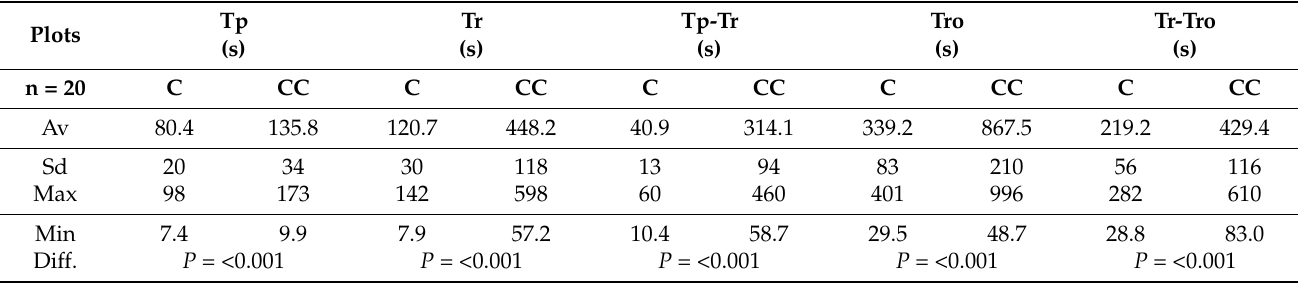
Table 3. Runoff parameters related to the hydrological responses in the catch crops (CC) and control plots (C). Av: Average; Sd: Standard deviation; Max: Maximum; Min: Minimum. Diff.: Differences. Tp: Time for ponding; Tr: Time for runoff generation; Tro: Time for runoff to the outlet.